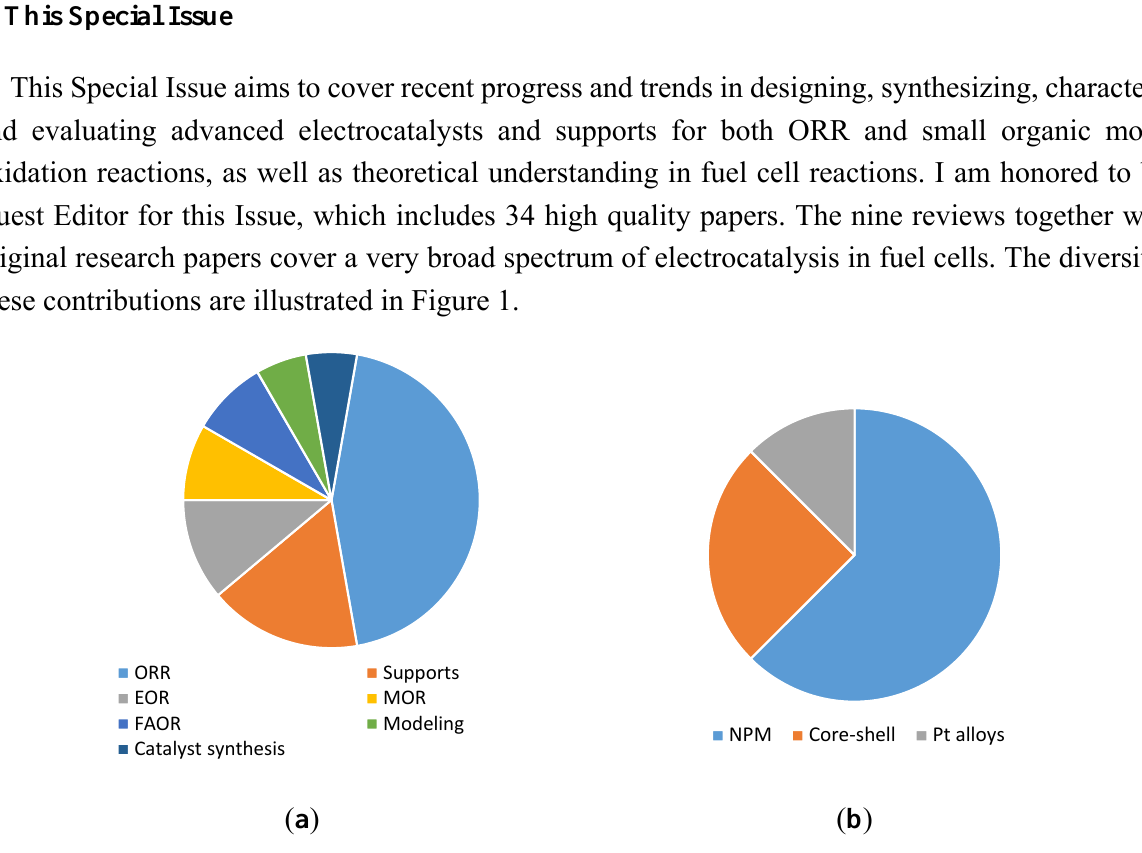
Figure 1. The distribution of the 34 contributions in this Special Issue ( a ) and the 16 contributions in oxygen reduction reaction; ( b ) in different research areas. ORR: oxygen reduction reaction; EOR: ethanol oxidation reaction; MOR: methanol oxidation reaction; FAOR: formic acid oxidation; NPM: non-precious